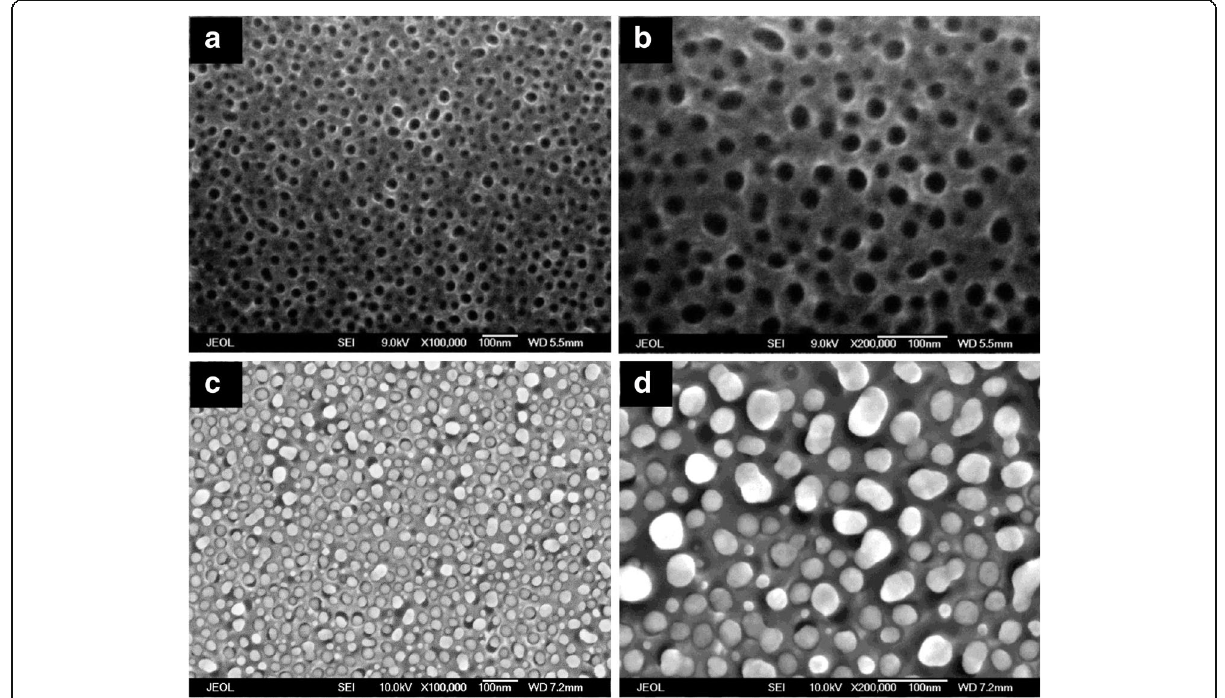
Fig. 1 Top-view scanning electron microscope images. a , b Anodic aluminum oxide (AAO) template. c , d Ag nanoparticle array grown in the AAO template. a, c magnification 100 K. b, d magnification 200